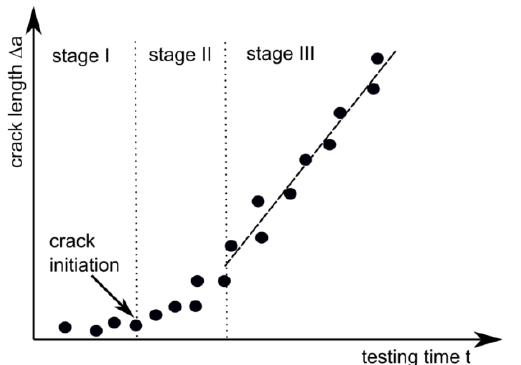
Figure 3. Crack propagation curve (crack length ∆ a marked as dots) for evaluating physical crack initiation with three characteristic stages: stage I (crack tip blunting), stage II (non-stationary stable crack growth) and stage III (stable crack growth).